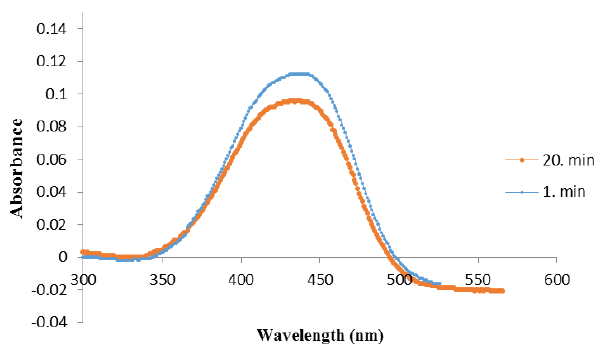
Figure 1. Absorbance spectra of bilirubin solution.